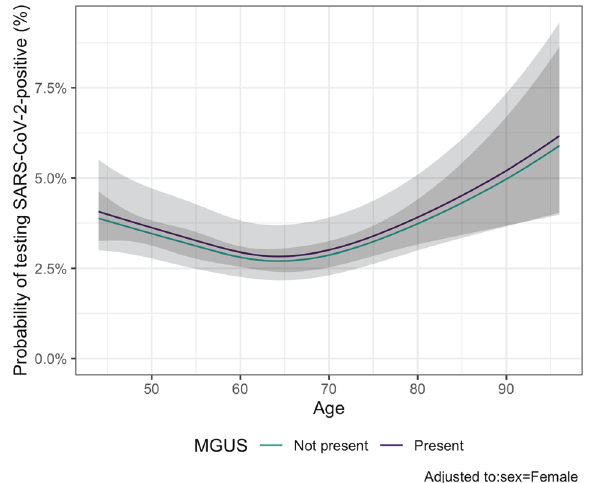
Fig. 2 Probability of testing SARS-CoV-2 positive. Probability of individuals with or without MGUS of testing positive for SARS-COV-2 according to age, adjusted to female sex.